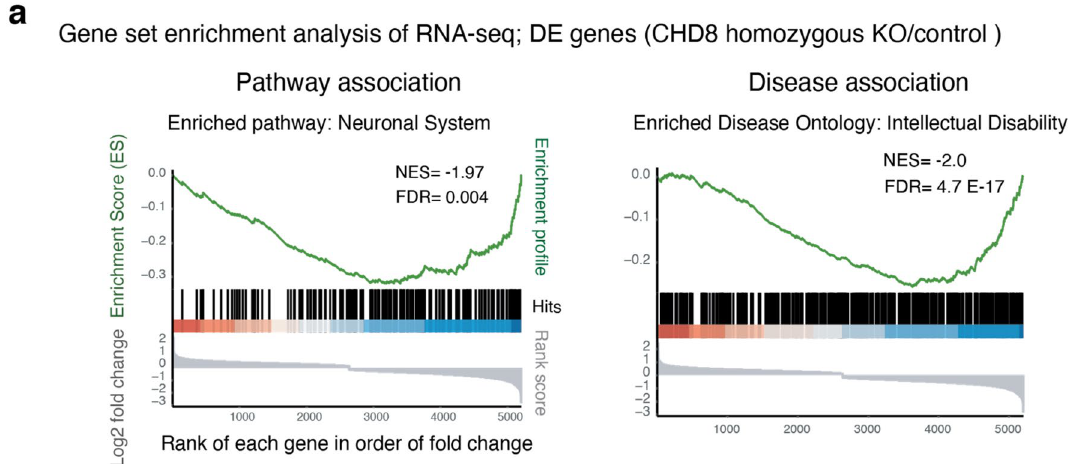
Figure 7. Analysis of gene expression changes in CHD8 KO neurons a, Gene Set Enrichment Analysis (GSEA) of the pathways and diseases for DE genes from CHD8 homozygous KO